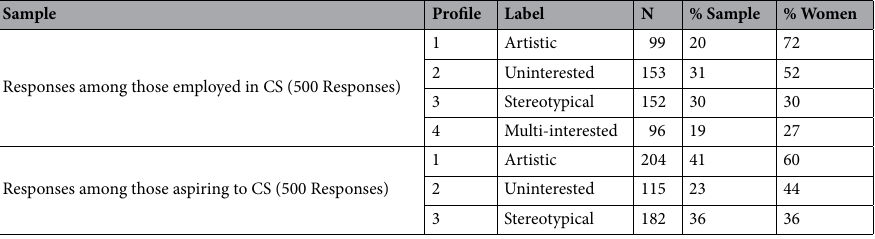
Table 1. Descriptions of latent profiles. Profiles are listed in descending order of representation for women. See the Online Appendix for values of each profile along all six interest score dimensions and for formalized comparisons of profiles to the O*NET estimate of CS interests.